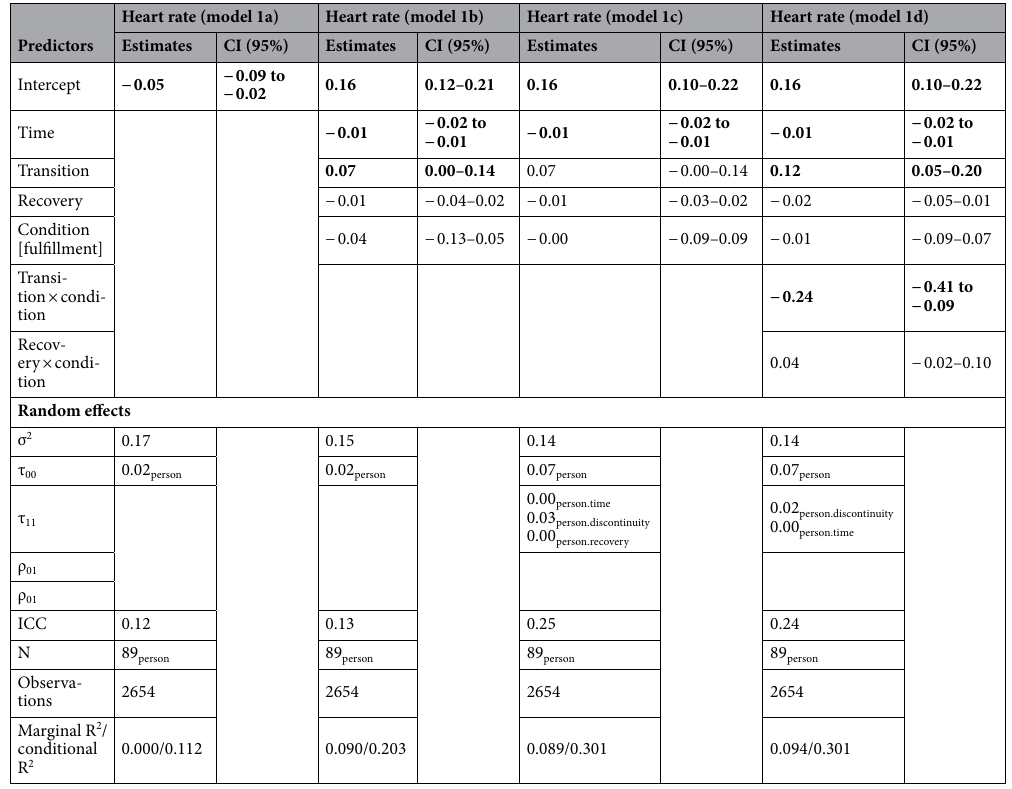
Table 2. Parameter estimates for discontinuous random coefficient models used to estimate effect of breach on HR. One participant was excluded from this analysis because the trial transitions were not recorded correctly in E-prime during the experiment. Condition contains two levels (0 = breach, 1 = fulfillment). Significant estimates are in bold.